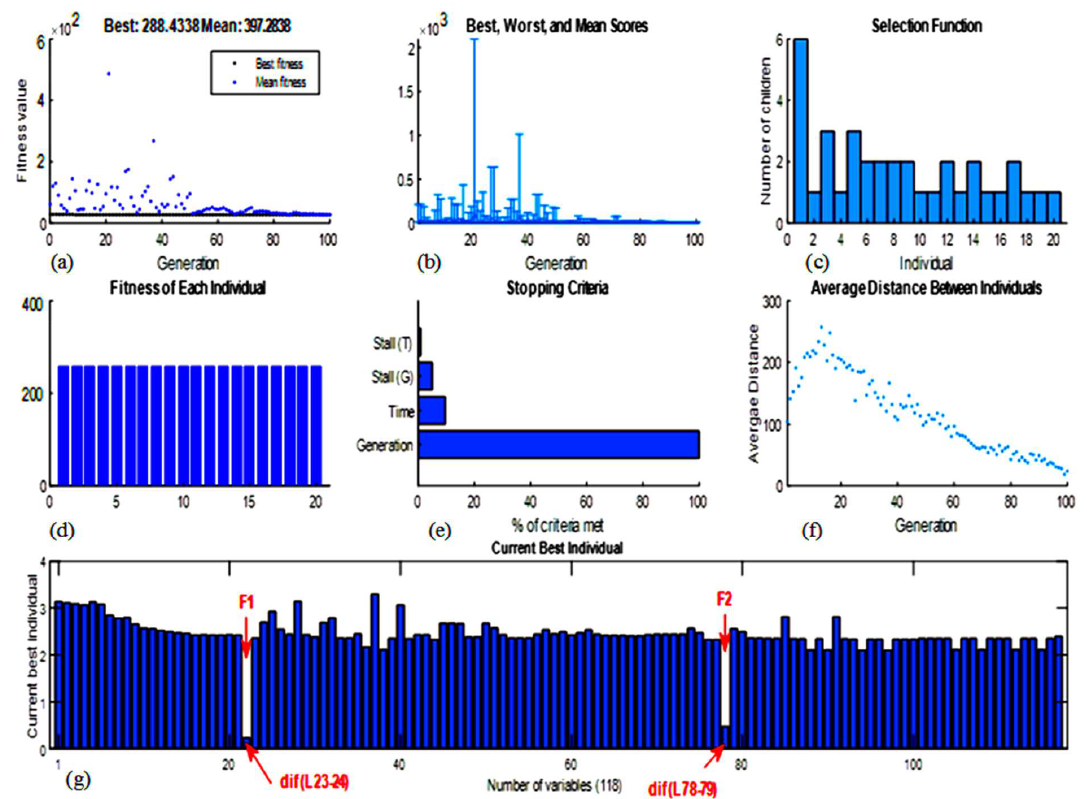
Figure 17. Results of the performance of the genetic algorithm to identify the fault section. According to Equation (42) to Equation (44) defined for each line, the voltage seen from both ends of the line without fault is equal, and for the two faulty lines, this voltage difference is not equal because of the current passing through each line. In lines without fault, a certain current passes, and in the faulty line, two currents enter the line from both sides. Therefore, for lines without fault dif ( L ), Equation (45) will be decreased and for faulty lines dif ( L ), Equation (45) will be incremental, but from there the goal is to optimize